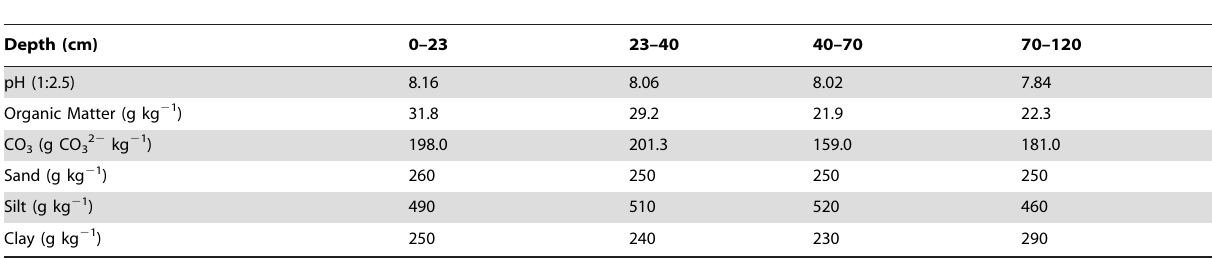
Table 1. Soil properties at the beginning of the experiment.